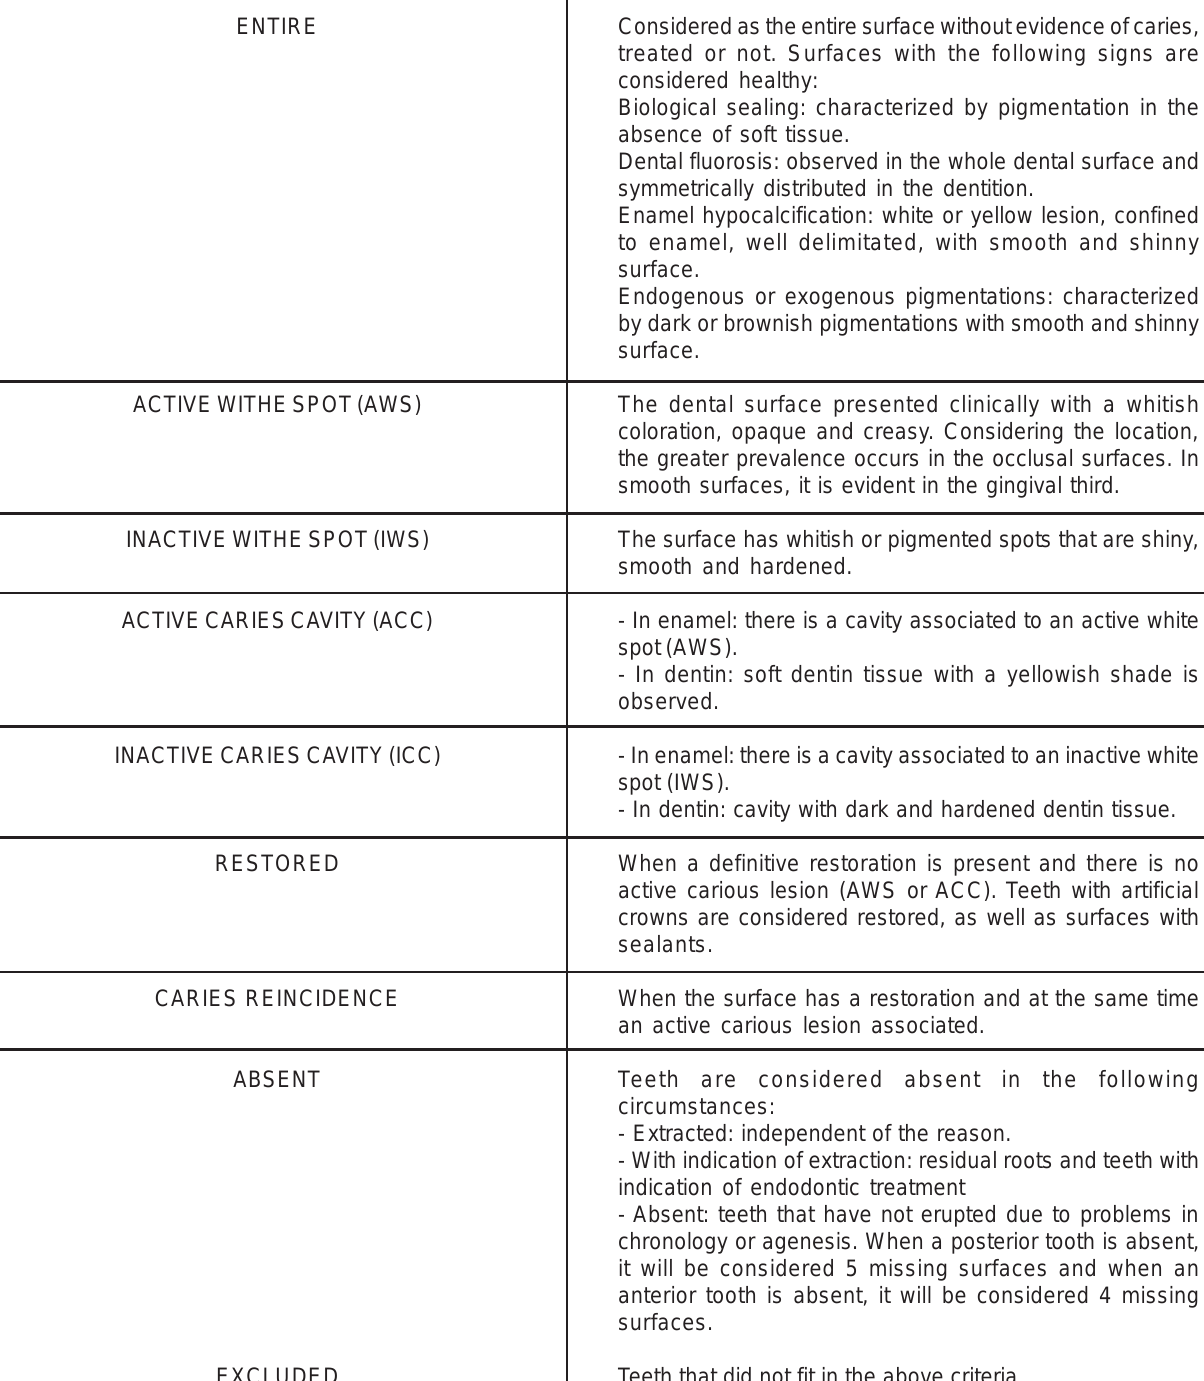
Figure 1- Criteria used in the modified DMFS